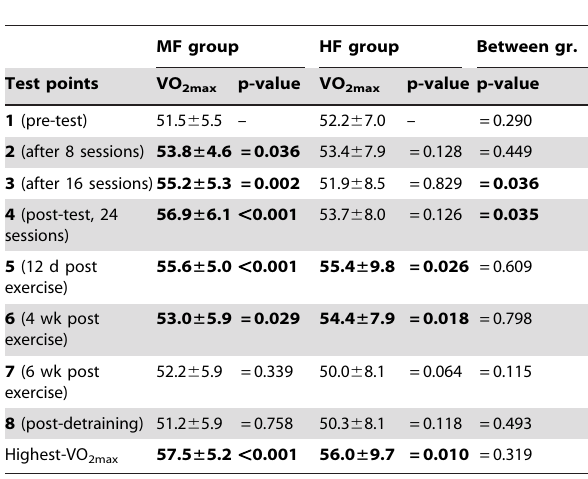
Table 2. Values of VO 2max expressed as means 6 SD for both groups during the training and detraining periods.